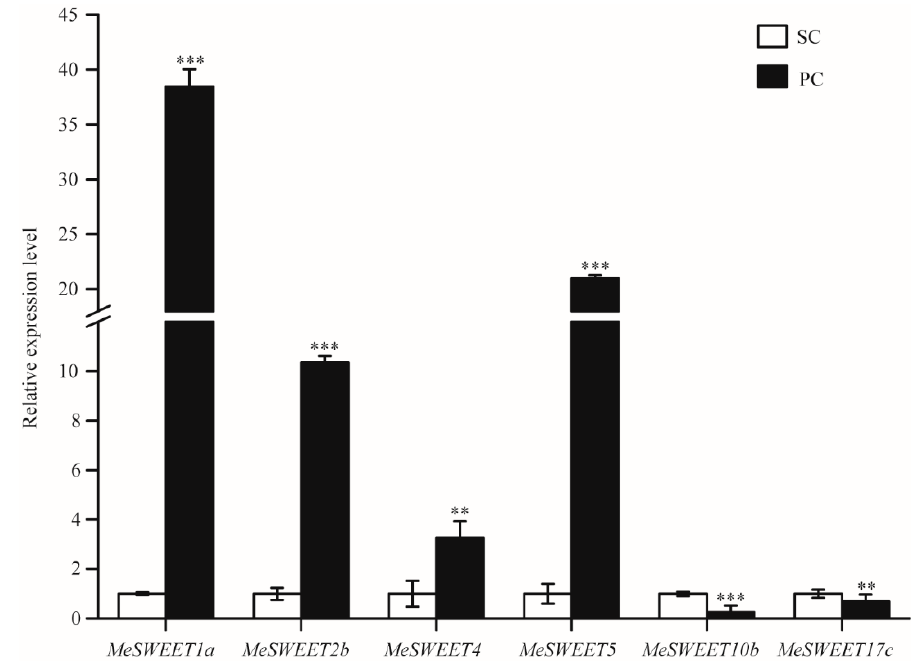
Figure 5. qRT-PCR analysis of the expression levels of MeSWEETs in PC compared to SC. The relative expression levels are normalized to MeActin . The x-axis represents the name of six MeSWEETs genes. The y-axis represents the relative expression levels of MeSWEETs . The data represent the means of three biological replicates. All data are the means ± SE of three independent experiments. Significant differences are indicated by asterisk (** p < 0.01, *** p < 0.001). SC: M. esculenta Crantz cv.